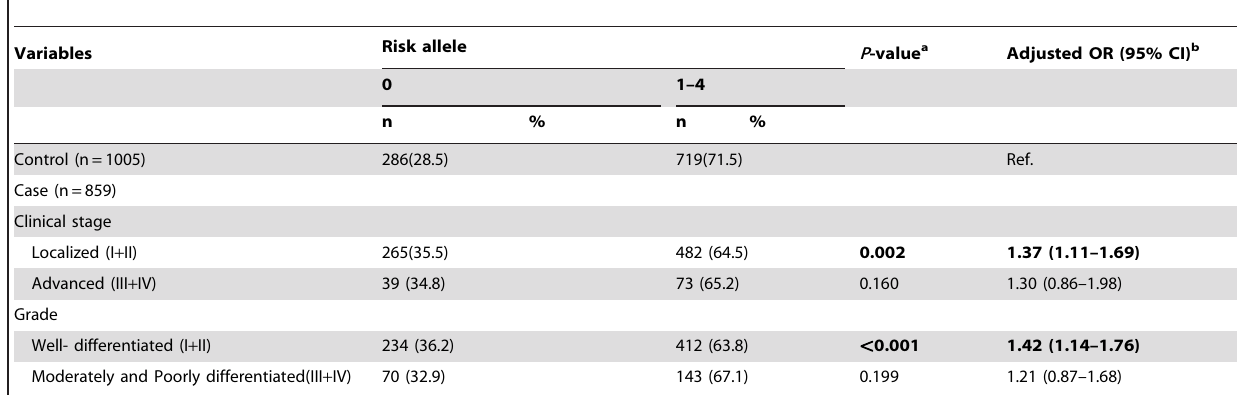
Table 4. Association between the combined genotypes of rs706209 and rs9332 polymorphisms and clinicopathologic characteristics of clear cell renal cell